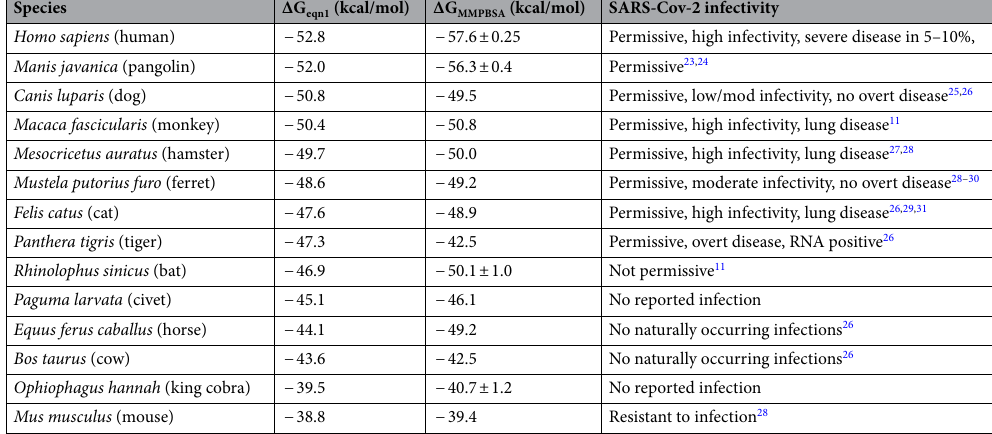
Table 2. Binding free energies of SARS-Cov-2 spike to ACE2 for different species and infection susceptibility reported by other